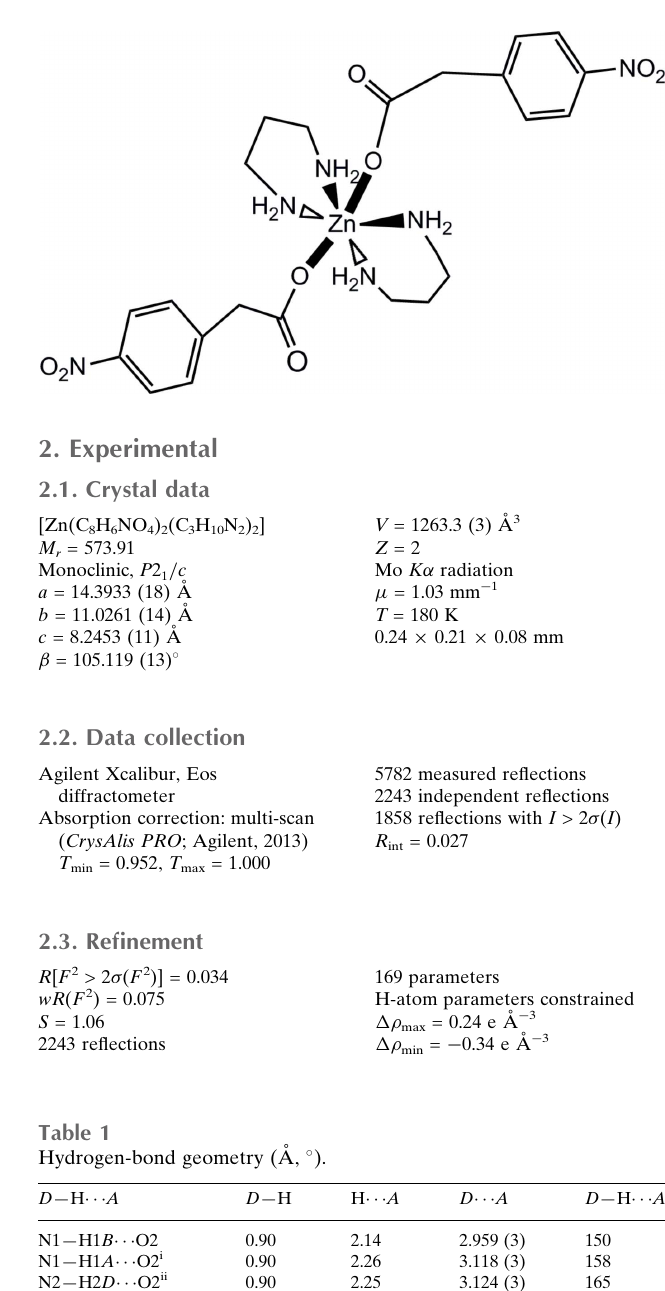
Sheng et al. (2014).